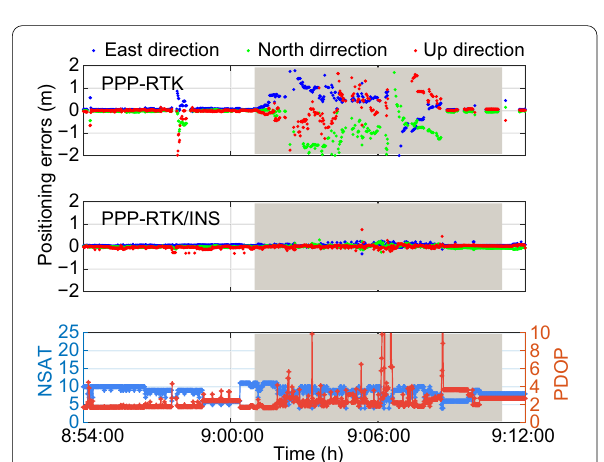
Fig. 8 Positioning series of PPP-RTK and tightly coupled PPP-RTK/INS in urban environments, respectively. The number of visible satellites (NSAT) and position dilution of precision (PDOP) series as well as the multipath series are also presented in the